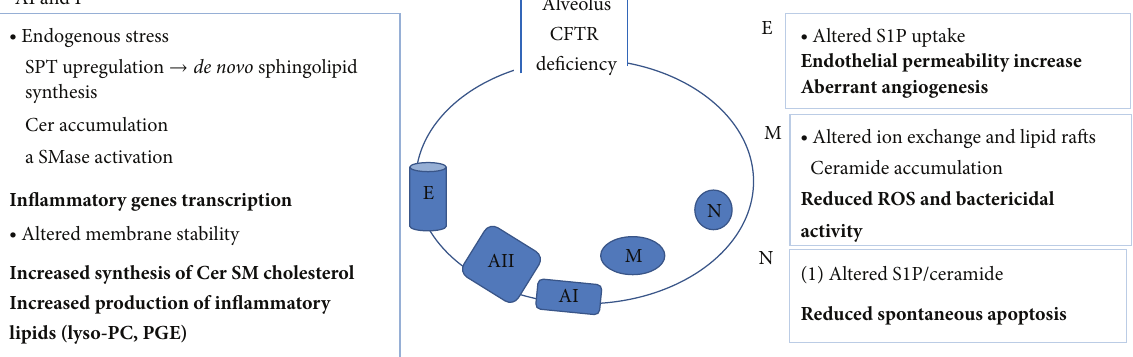
Figure 2: Sphingolipids modulation and bioactivity in cystic fibrosis: prevalent sphingolipids alteration in the alveolar lung compartment and induced responses in endothelial cells (E), alveolar epithelial cells (alveolar type 1 AI, alveolar type 2, AII), macrophages (M), and neutrophils (N). SPT, Serine Palmitoyl Transferase; Cer, ceramide; a SMase, acid Sphingomyelinase; SM, sphingomyelin; lyso-PC, lysophosphatidyl choline; PGE, prostaglandin; S1P, sphingosine-1-phosphate; ROS, reactive oxygen